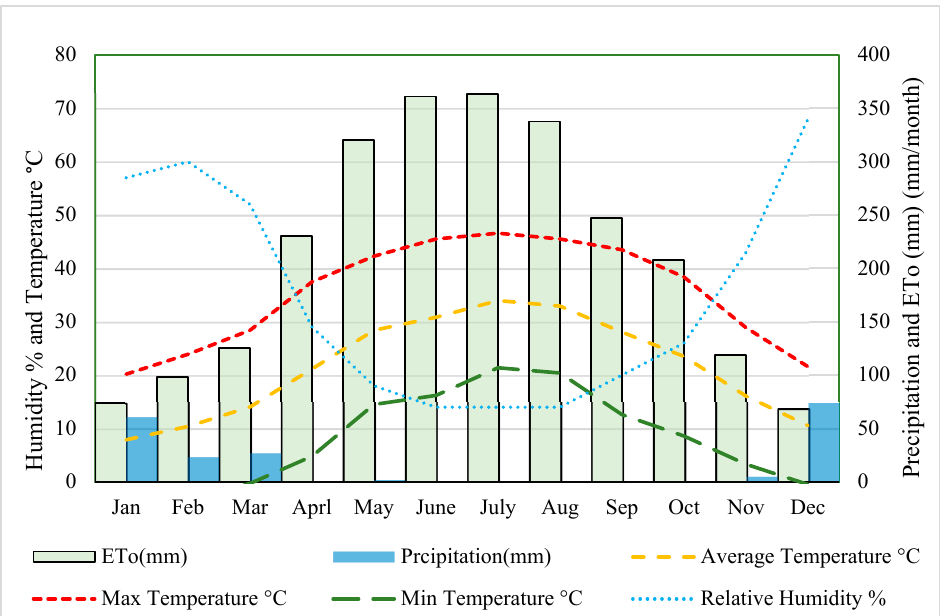
Figure 2. Monthly precipitation, relative humidity, actual evaporation, maximum, minimum, and mean temperature of North Erbil and surrounding areas recorded for 2021 years.